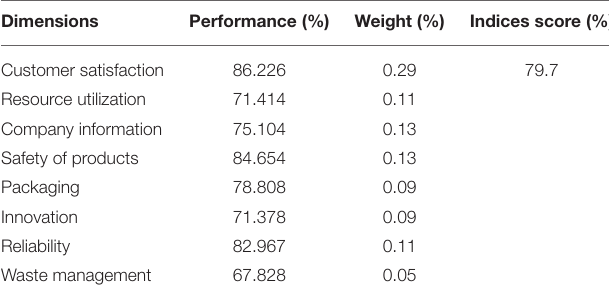
TABLE 8 | Calculated performance indices score of